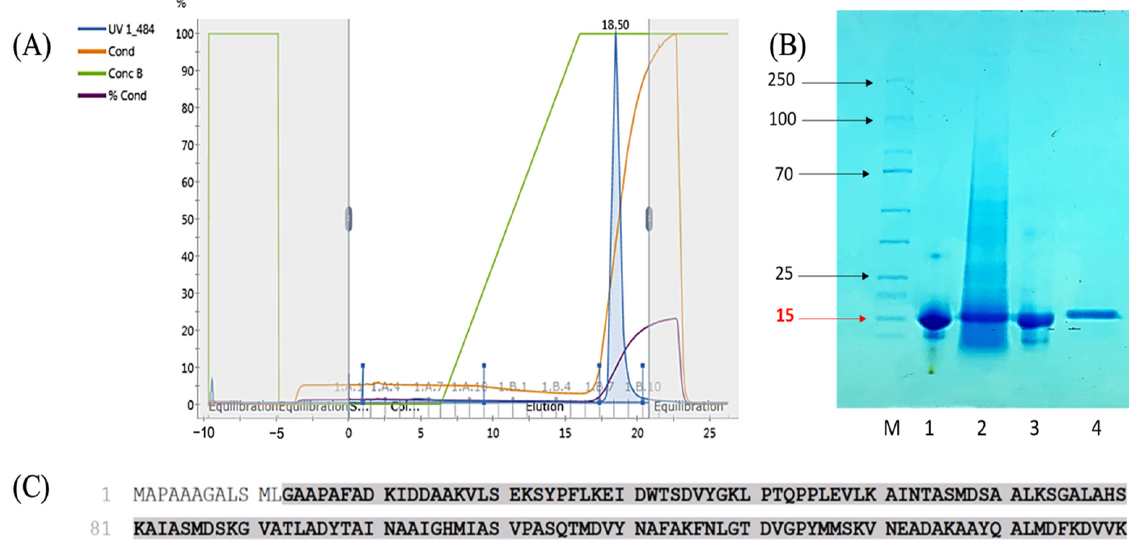
Figure 1. Chromatogram of S. tridacnidorum purified PCP using ÄKTA™ PURE system ( A ). SDS-PAGE analysis of PCP extracted from S. tridacnidorum ( B ). Lane M represent marker proteins, PCP commercial standard ( lane 1 ), crude PCP ( lane 2 ), desalted PCP ( lane 3 ) and a single band of purified PCP with ÄKTA™ PURE system ( lane 4 ). PCP sequence matched to accession SimA3.s6014_g3 ( Symbiodinium clade A) using PEAKS 8.5 software ( C ). Shaded amino acid sequence denotes identified peptides and sequence coverage of trypsin-based PCP digestion.